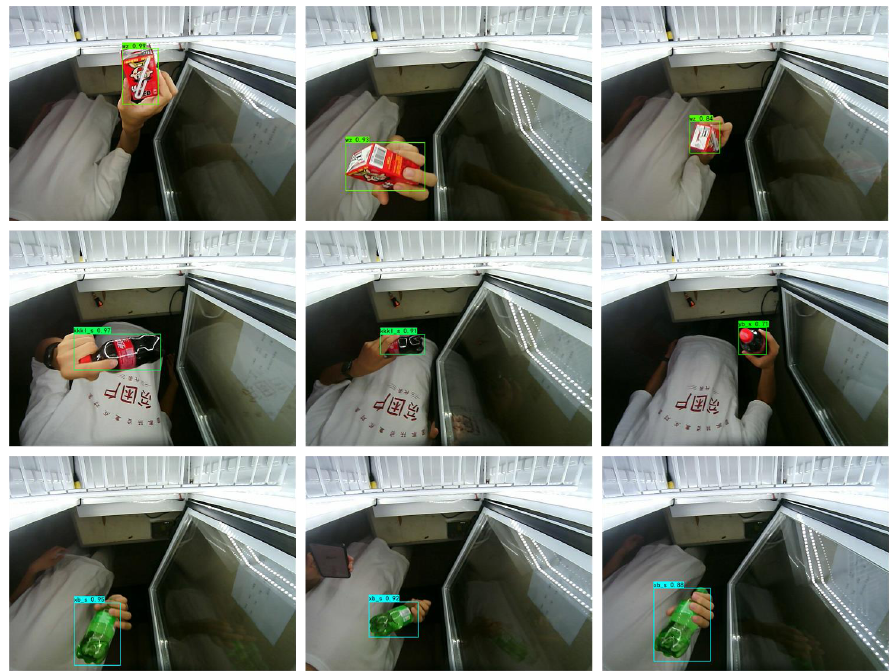
Figure 17. Detection results for small commodities with different degrees of occlusion.